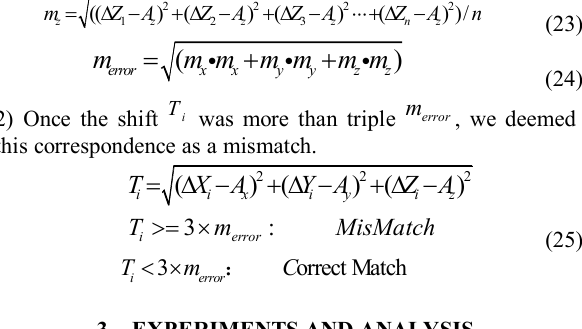
Figure 4. The Nadir-looking strips in the adjacent orbits: (a) The nadir-looking strip acquired from the first orbit; (b) The nadir-looking strip acquired from the second orbit; (c) The enlarged drawing of the overlapping area between the two strips